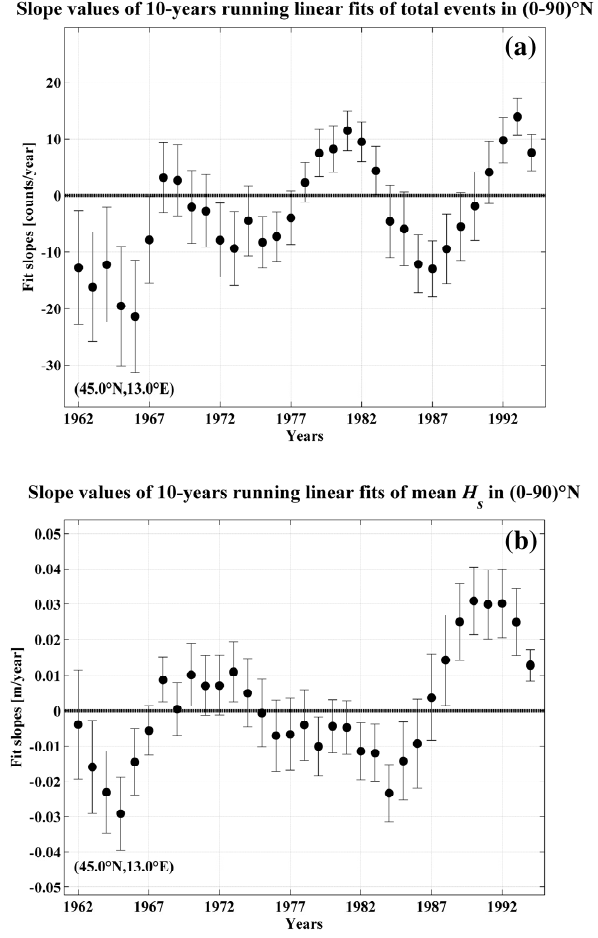
Figure 6. Panel (a) and (b) show the slopes of the 10-years running linear fits of, Fig. 6. Panel (a) and (b) show the slopes of the 10-years running linear fits of, respectively, the total number of sea states and the respectively, the total number of sea states and the mean annual H s values as shown in mean annual H s values as shown in Fig. 5 (a) and (b). The i -th data Figure 5 (a) and (b). The i th data point represents the slope of the linear regression point represents the slope of the linear regression through the years from i 5 to i +5. Error bars in both panels are equal to ± σ through the years from i – 5 to i + 5. Error bars in both panels are equal to ± σ .